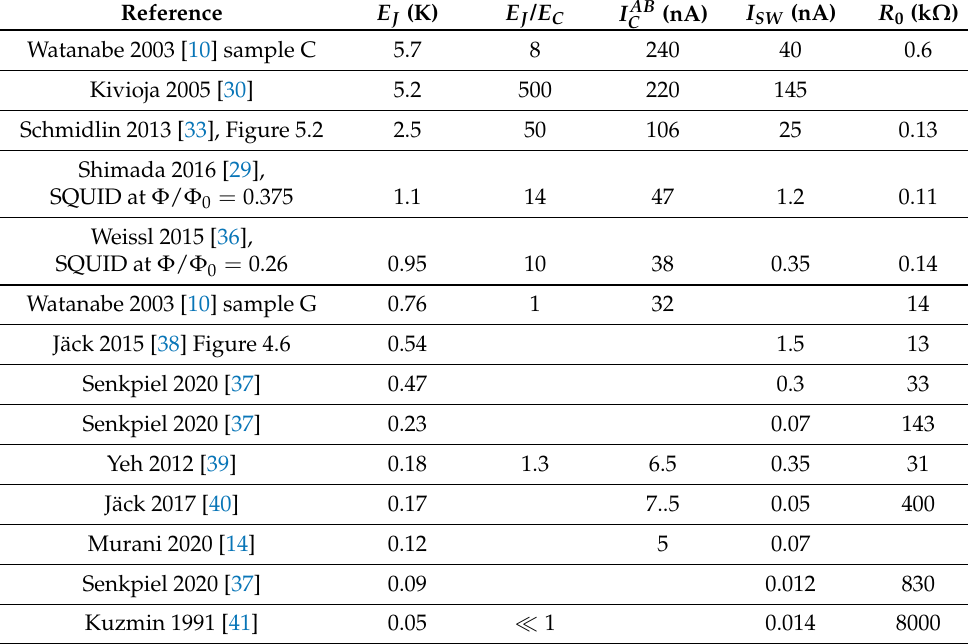
Table 2. The literature data on I SW and R 0 , ranked by E J